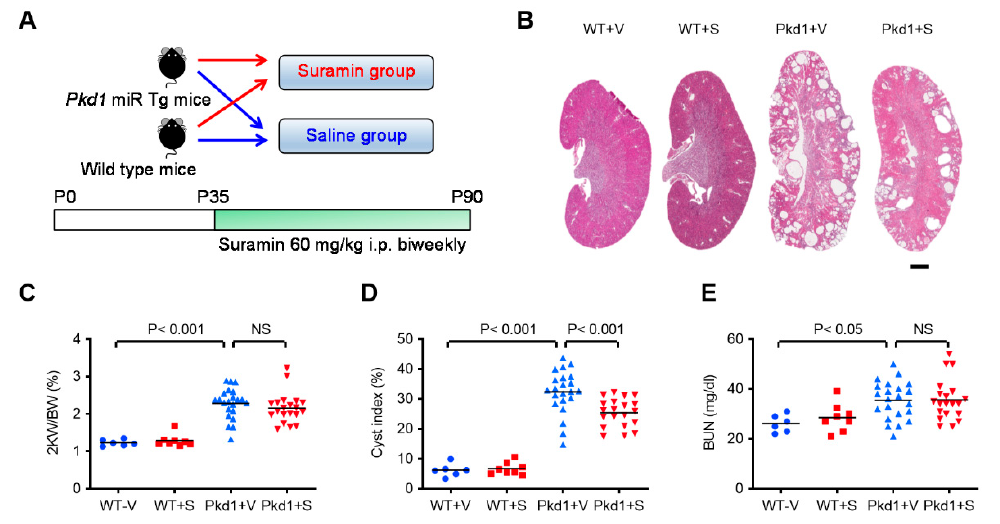
Figure 2. Suramin treatment reduces cyst burden in Pkd1 miR Tg mice. ( A ) Schematic illustration of the experimental groups and the time frame of suramin administration. ( B ) Representative images of whole kidney sections (H&E stain) in the suramin-treated Pkd1 -miR Tg mice compared to the vehicle-treated controls. ( C ) Kidney-to-body weight ratios, ( D ) cystic indices, and ( E ) BUN levels in different experimental groups as indicated (n = 6, 8, 22, and 20 per group, respectively). Data are mean ± SEM. S, suramin; V, vehicle. Scale bar, 1 mm.